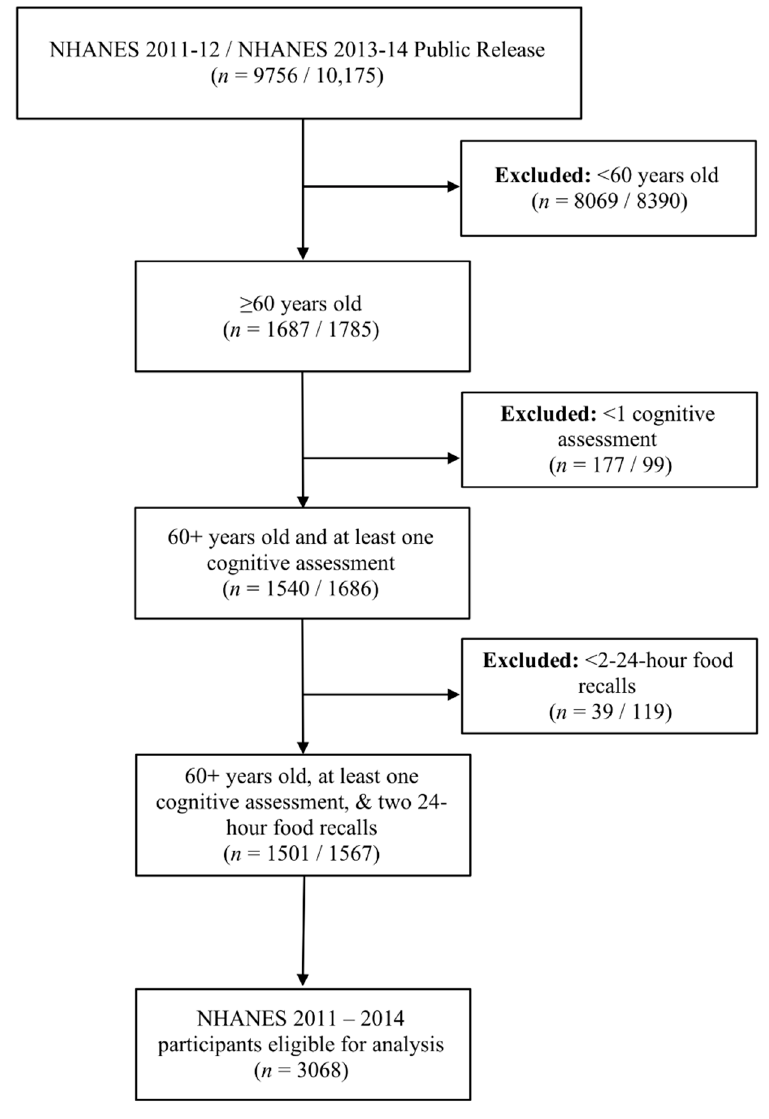
Figure 1. Diagram of the flow of participants included in this analysis.